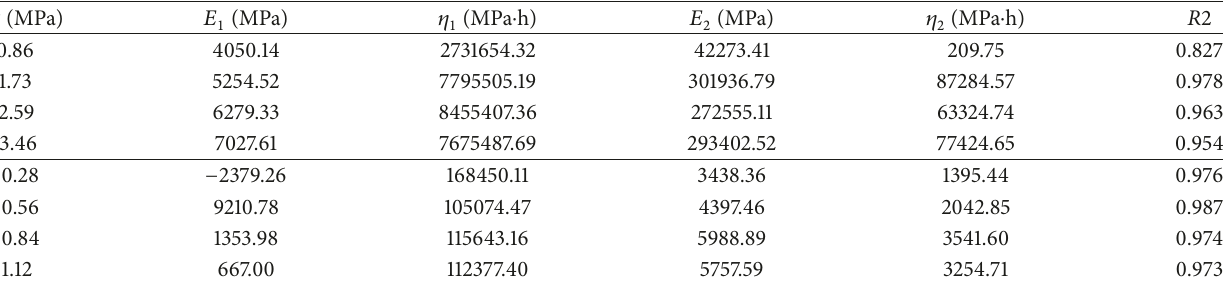
Figure 12: Comparison between Burgers creep model curves with the experimental result (a) under compressive stress and (b) under tensile stress. Table 1: Burgers creep model parameters of red